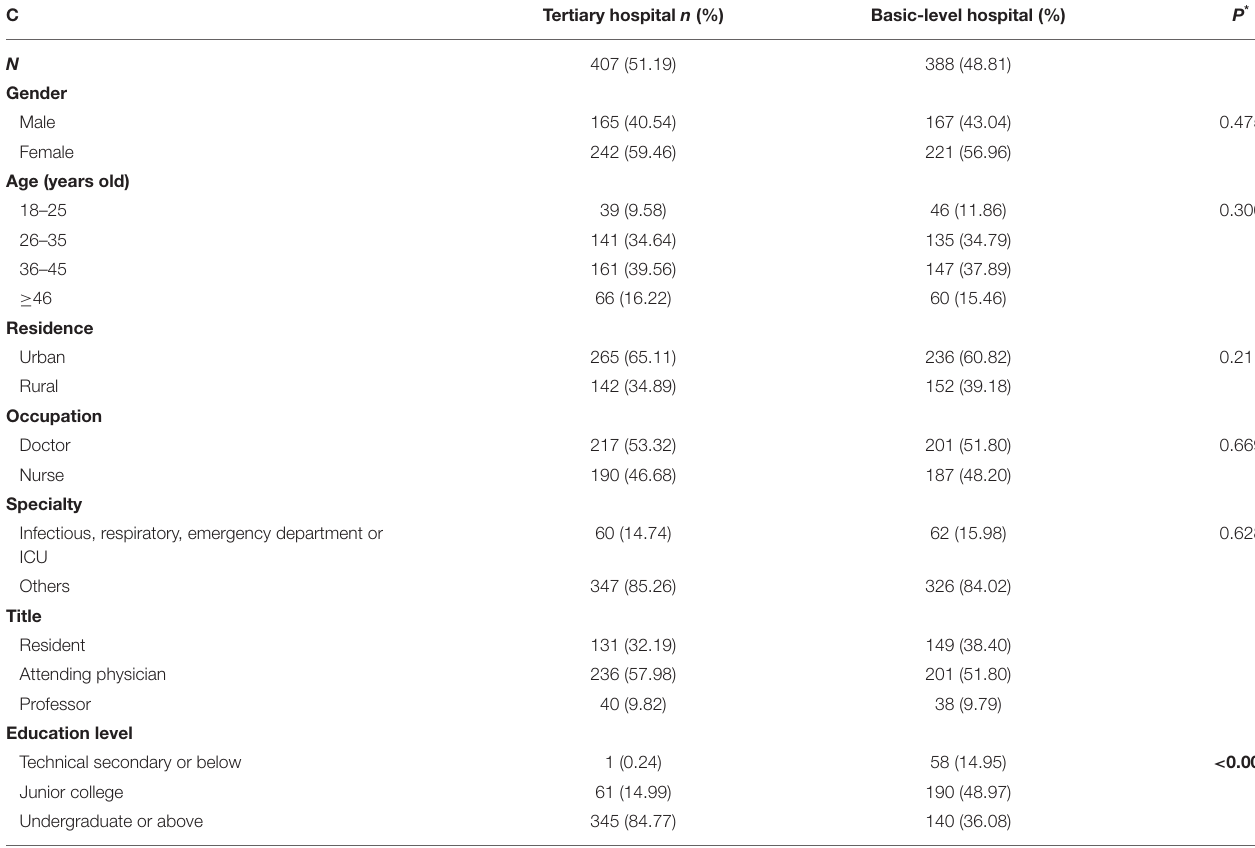
TABLE 1 | Demographic characterists of the study